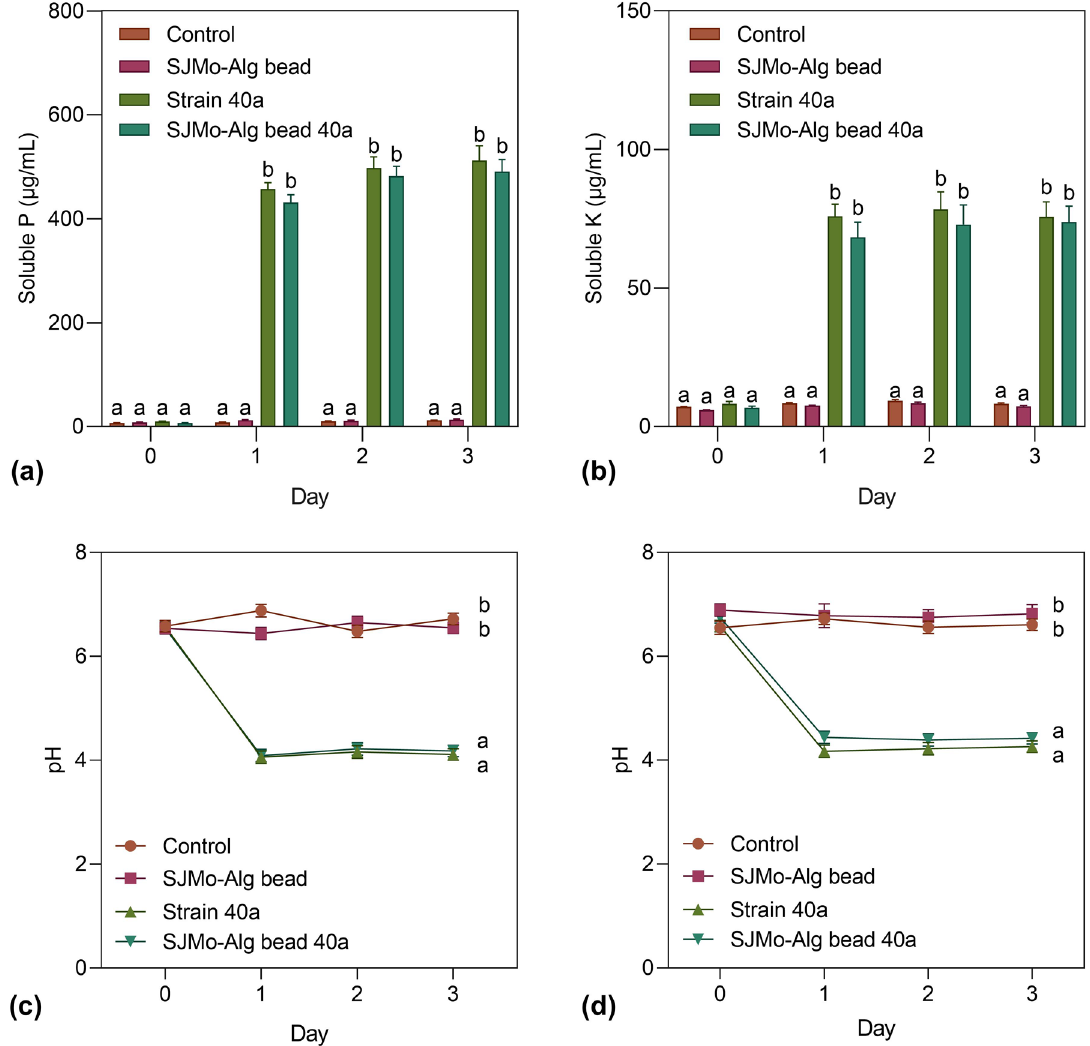
Figure 6. Comparison of P and K solubilization activity of free cells and encapsulated cells of strain 40a (SJMo- Alg bead 40a). Data represent mean values ± standard deviations (n = 3). Different letters indicate statistically significant differences between factors (two-way ANOVA + Tukey multiple comparisons test at P < 0.05). The graphs were visualized in GraphPad PRISM software (v 8.02; GraphPad, Inc., MN, USA; www. graph pad.